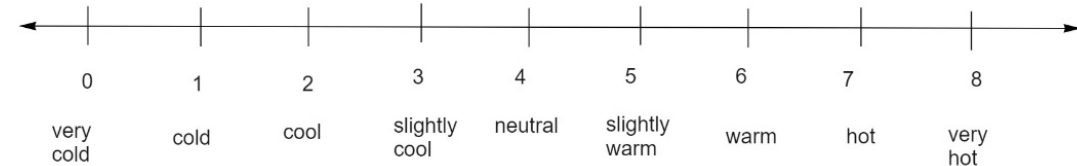
Figure 6. Thermal sensation evaluation index.